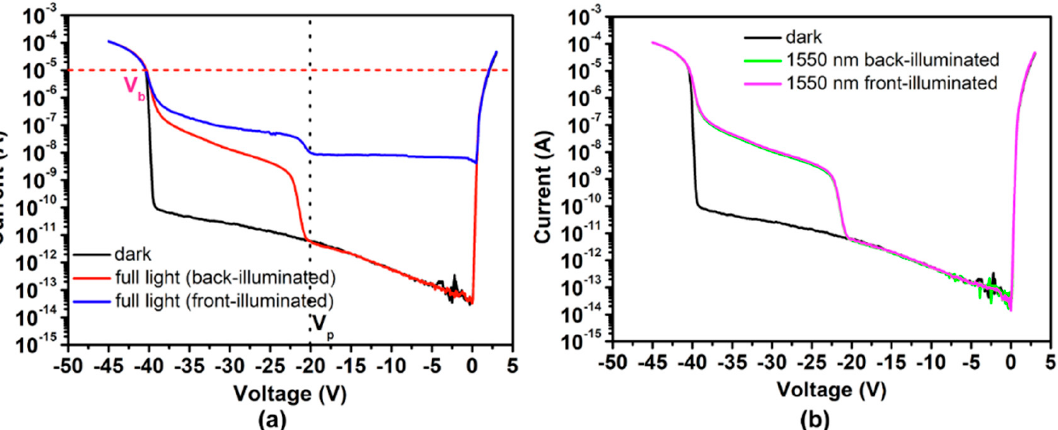
Figure 40. Electrical properties of the double side illuminated SAGCM InGaAs/InP APDs under ( a ) a full-spectrum light source and ( b ) 1550 nm illumination. Reproduced with permission from [93], Elsevier, 2022.